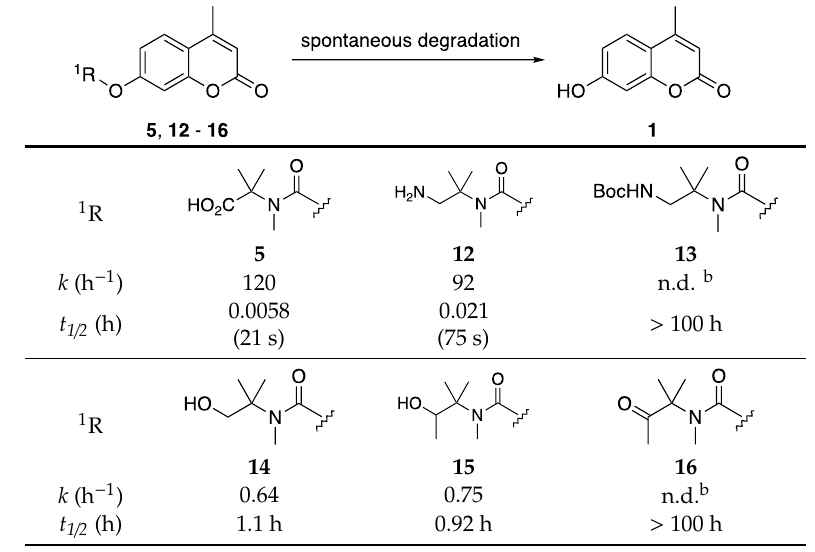
Table 2. Summary of the reaction kinetics parameters of trimethyl carbamate probes possessing different functional groups a.